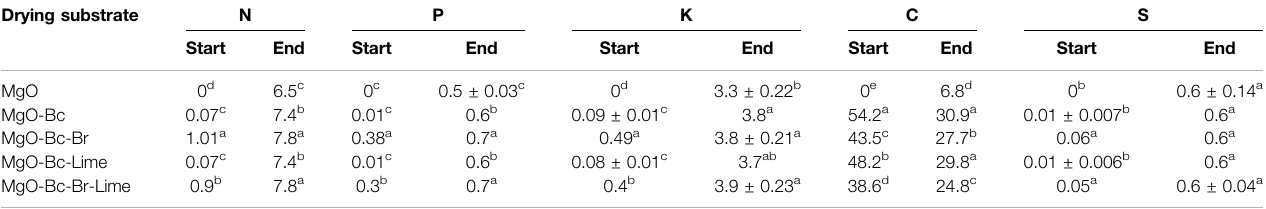
TABLE 4 | The elemental composition (as % of TS) of the drying substrate at the start and at the end, after dehydrating urine for 5.6 days.